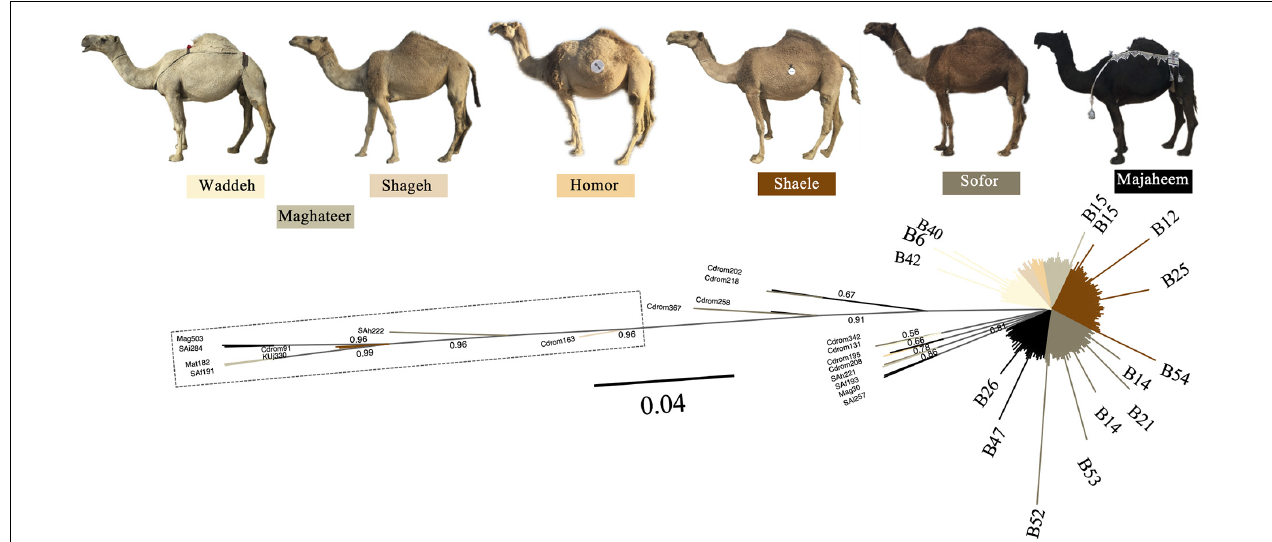
FIGURE 6 | Unrooted phylogenetic tree of Mezayen camel-type haplotypes. Values above branches correspond to the posterior probability values. Posterior probability values = 1 were omitted for clarity. The dashed box contains haplotype A sequences. Non-major (low frequency) B haplotypes were illustrated at the tip of the branches. Photos are taken by